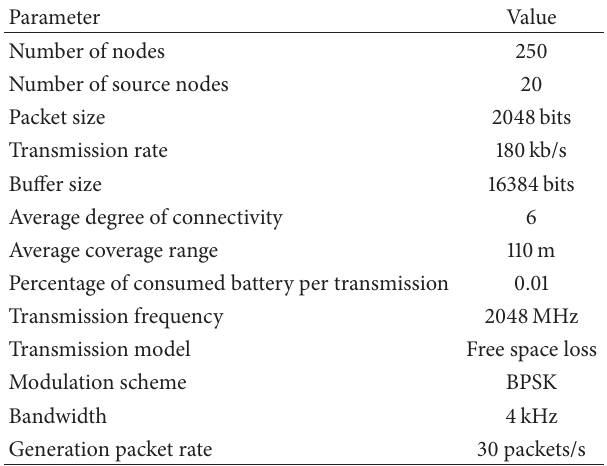
Table 2: Simulation